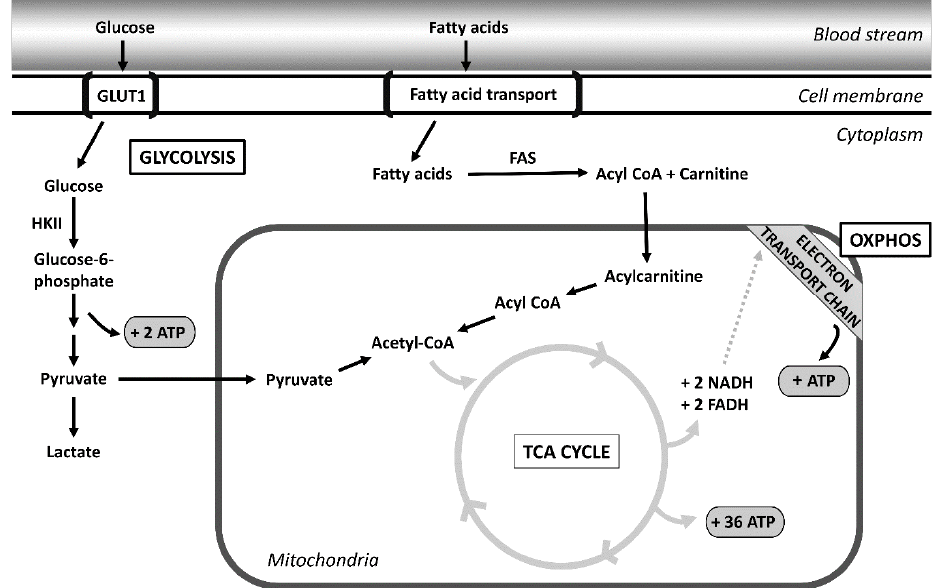
Figure 1. Metabolomic pathways of the cell. Glucose enters the cell through the bloodstream via GLUT1 transporters. Glucose then is broken down by glycolysis producing 2 ATPs and pyruvate. Pyruvate is then transferred to the TCA cycle, which generates NADH and FADH. NADH and FADH transfer their electrons through oxidative phosphorylation (OXPHOS) to generate ATP. Fatty acids are broken down as an alternative form of energy for the cell. Fatty acids enter the cell through membrane transporters. Fatty acids then undergo beta-oxidation, which results in the production of acetyl-CoA. Acetyl-CoA then enters the TCA cycle, which again produces NADH and FADH to use in the OXPHOS pathway. Abbreviations: FAS: fatty acid synthetase; HKII: hexokinase II; ATP: adenosine triphosphate.